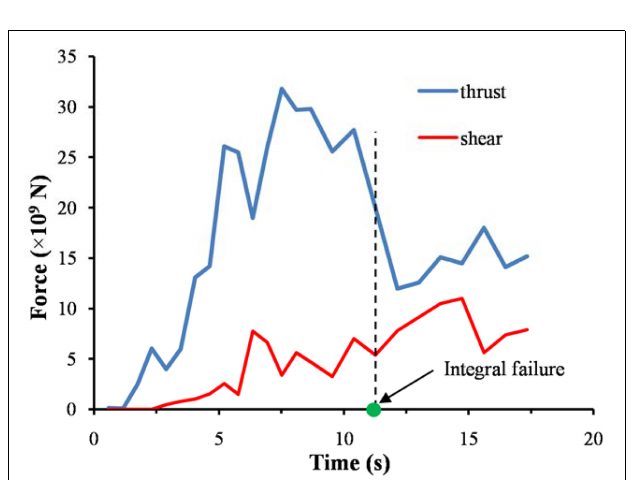
FIGURE 15 | Evolution of thrust and shear force during the entrainment process. The magnitude of the thrust decreases abruptly at the time of integral failure of the substrate but remains higher than the magnitude of shear.